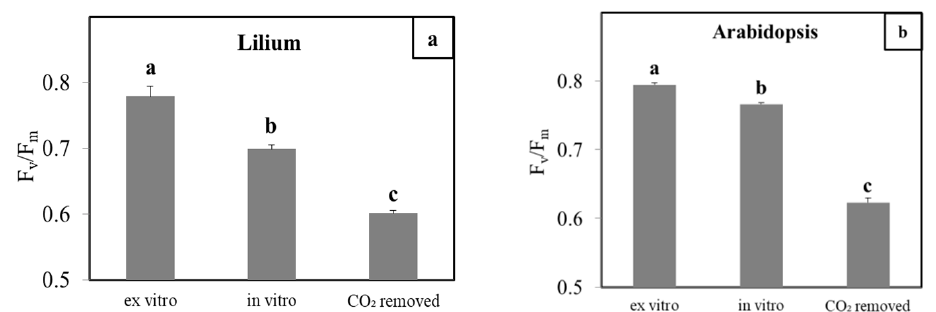
Figure 6. F v /F m in lilies ( a ) and Arabidopsis ( b ) grown ex vitro, in vitro, and when (most) of the CO 2 was removed from the headspace. Different letter indicate significant differences between treatments ( p < 0.05).